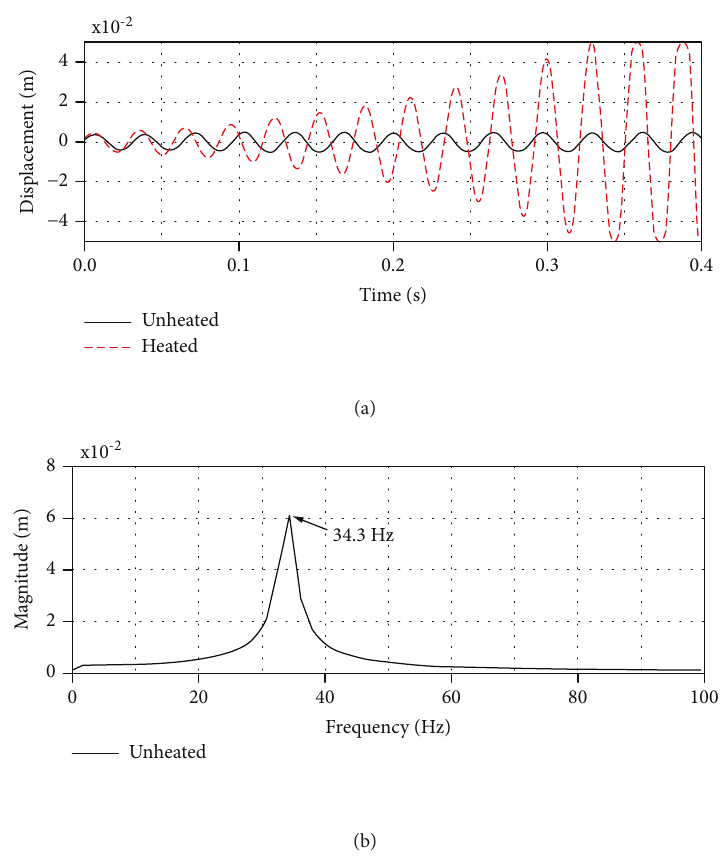
Figure 11: Time histories and FFT spectrum of wing tip displacement at M